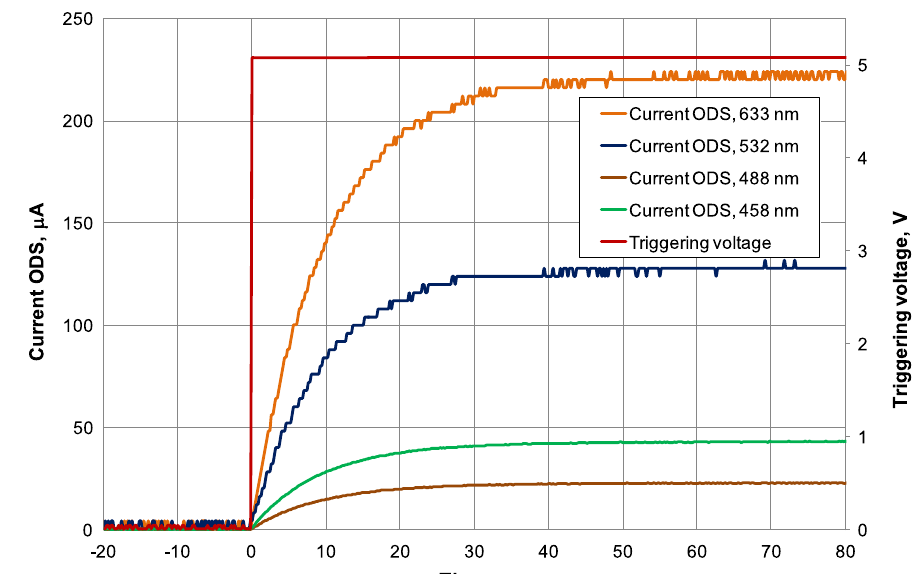
Fig. 6. Time-resolved spectrally fi ltered optical signal of the DC-driven CoB (ID VSL085). Triggering electrical forward voltage is shown in red for